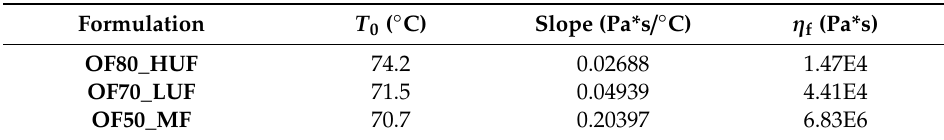
Table 2. Rheological data obtained from the curves of Figure 2 ( T 0 is the onset temperature of curing, η f is the samples final viscosity) .